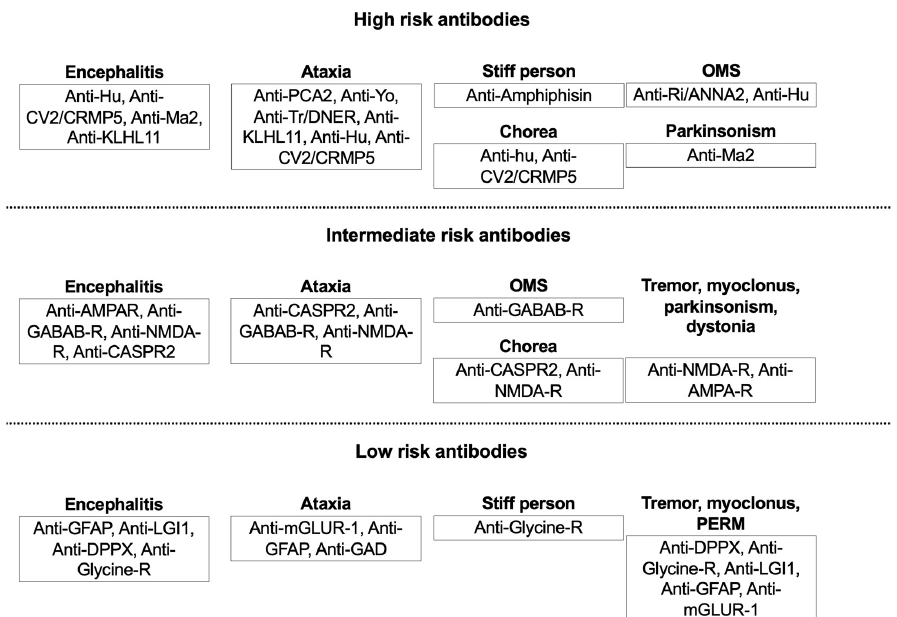
Figure 2. Main antibodies found in association with different paraneoplastic movement disorders, stratified per probability of having an underlying neoplastic condition. High-risk antibodies are associated with 70% probability or more of an underlying cancer. Intermediate risk antibodies with 30–70%, and low-risk antibodies with less than 30% probability of developing cancer, respectively. Each movement disorder is represented within one of three categories, together with most relevant associated antibodies. A huge overlap exists between some of these conditions, and same antibody may be found in association with different movement disorders. OMS, opsoclonus-myoclonus; OMS, opsoclonus-myoclonus ataxia syndrome; PERM, progressive encephalomyelitis with rigidity and myoclonus.